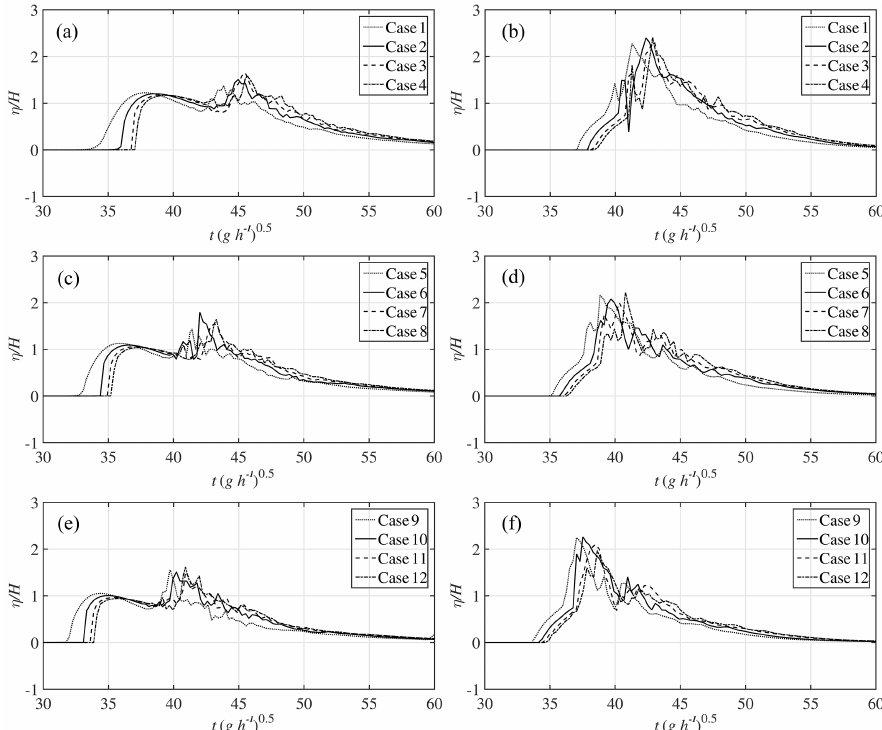
Figure 7. Time series of relative wave elevation in Tank 2: (a) , (c) and (e) x = 0m; (b) , (d) and (f) x =